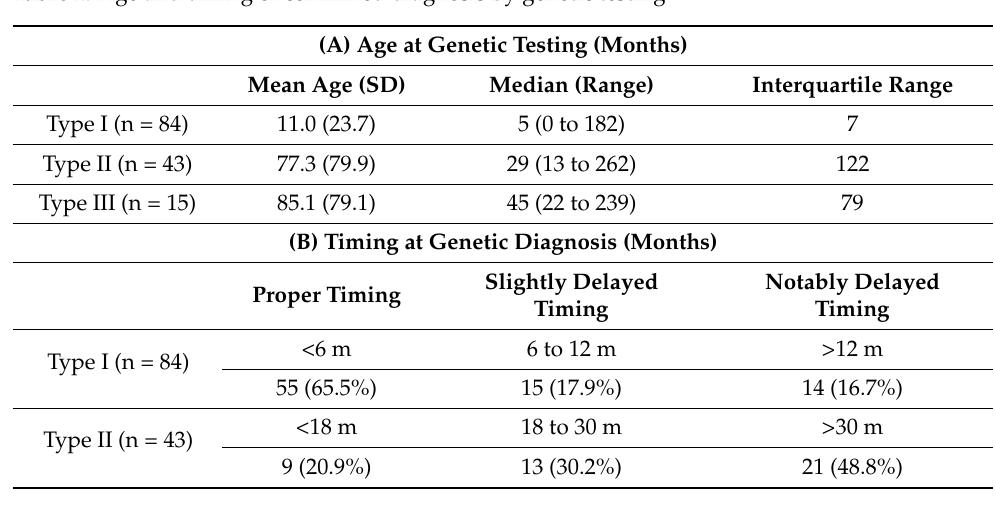
Table 2. Age and timing of confirmed diagnosis by genetic testing.